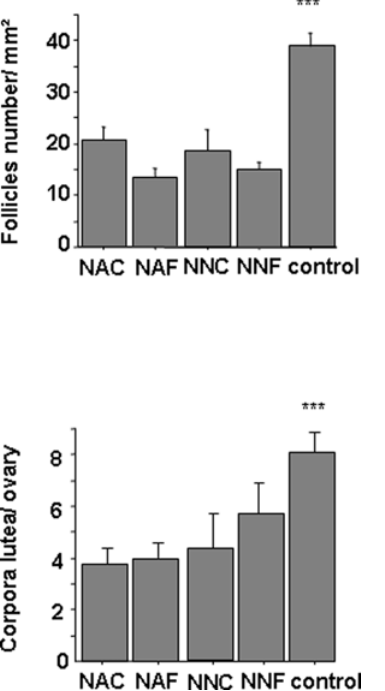
Figure 3.Follicle density and number of corpora lutea by ovary in each group one month after grafting . n=5 mice/group. Data are expressed as mean density 6 SEM. The asterisks indicate significant differences between groups of manipulated mice and unmanipulated mice (control) (p , 0.001)